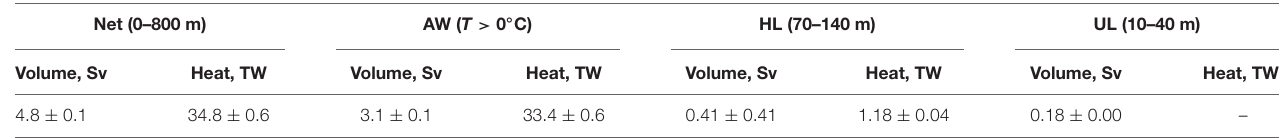
FIGURE 3 | Depth-integrated transports (A) in the upper 800-m layer and (B) in the AW layer. Monthly net volume transport across the Laptev Sea slope (C) in the upper 800-m layer, (D) in the AW layer, (E) in the UL (10–40 m) and (F) in the HL (70–140 m). Monthly heat transport (G) and heat transport density (H) in the AW layer across the 125E section in 2013–2018. Dashed lines in (C,D) show the 2013–2015 and 2015–2018 means. Gray areas in (C,G) represent one standard deviation intervals. TABLE 2 | Mean volume and heat transports across the Laptev Sea section in the upper ∼ 800 m (Net), Atlantic Water (AW), halocline (HL), and upper ocean (UL) layers in